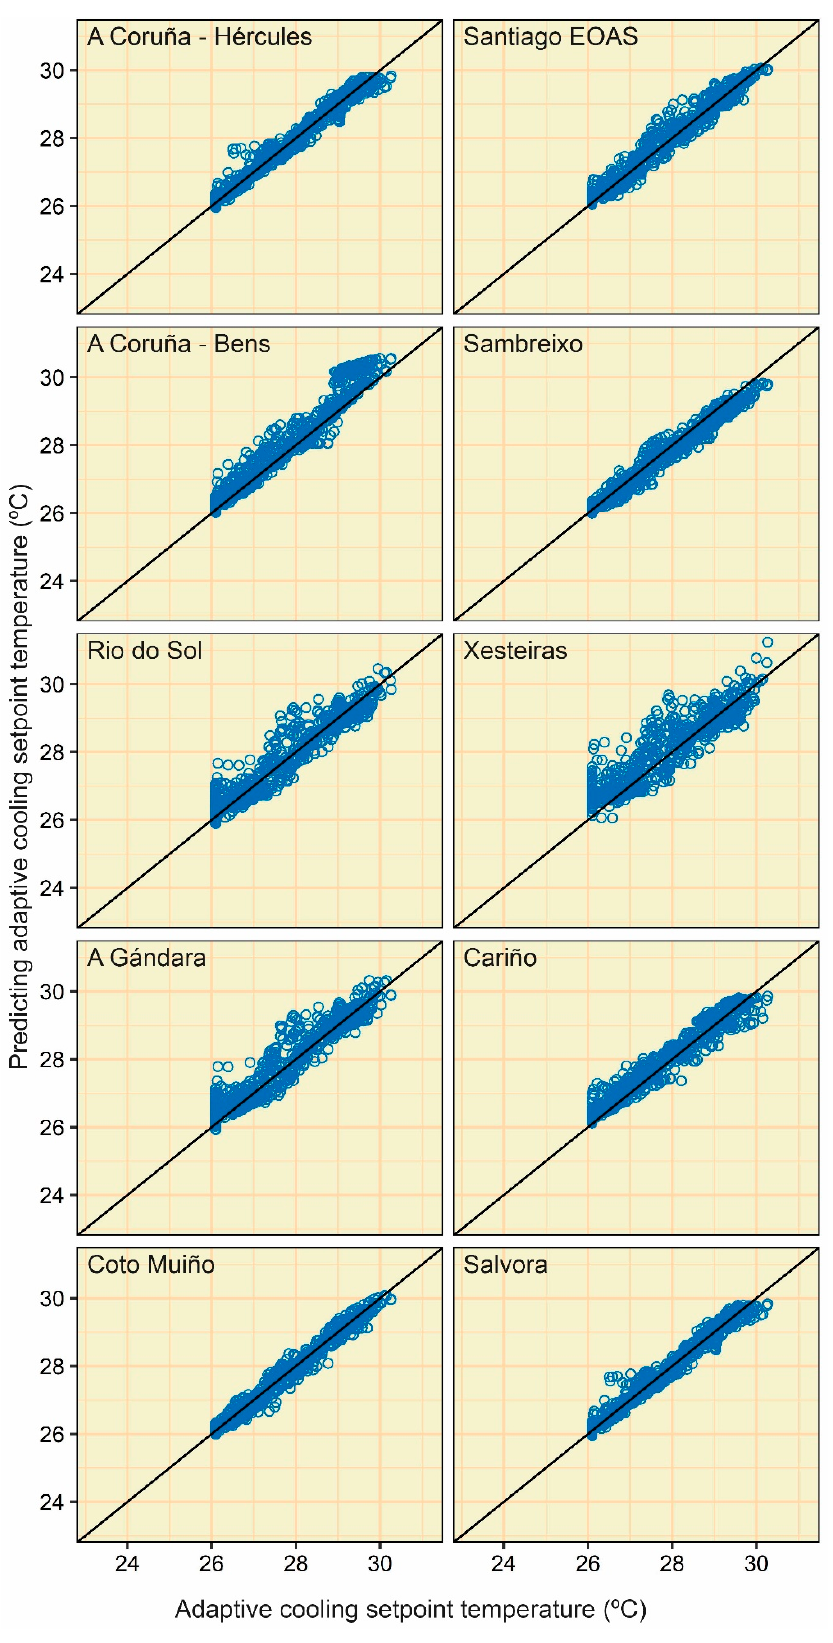
Figure A12. Point clouds between the actual and predicting adaptive cooling setpoint temperature values (category III) of the MLP (approach 2).